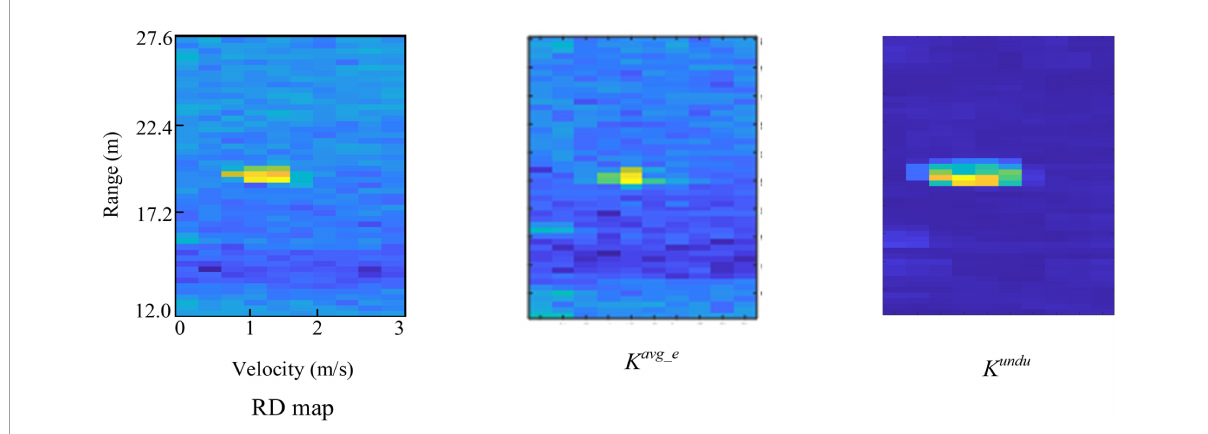
FIGURE3 K avg_e and K undu extracted from the same region-of-interest (RoI) in an range-Doppler (RD) map.